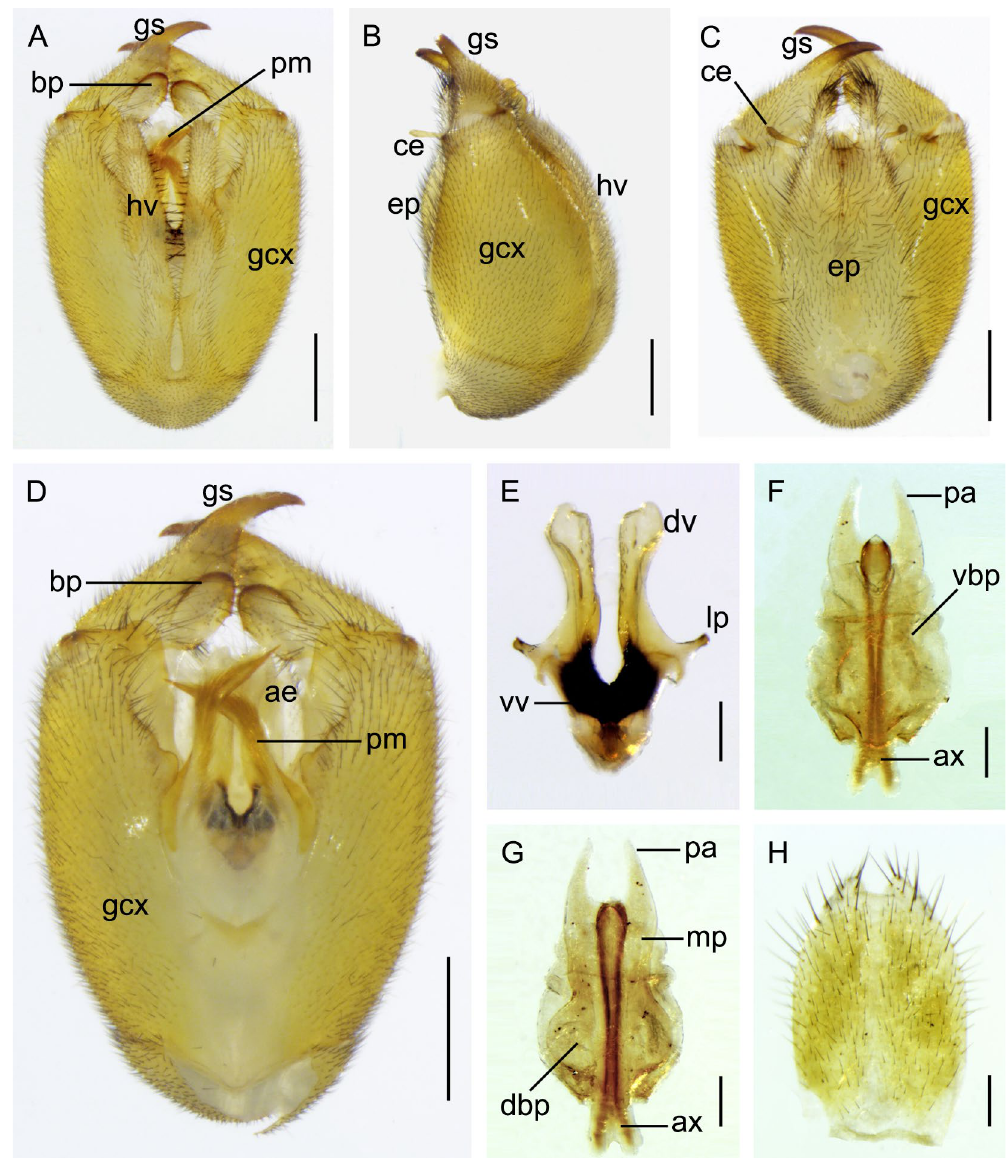
Fig. 10. Genitalia of Cerapanorpa xuebaodinga sp. nov. A–C . Male genital bulb in ventral, lateral and dorsal views. D . Male genital bulb with hypandrium removed in ventral view. E . Aedeagus in ventral view. F–G . Female medigynium in ventral and dorsal views. H . Female subgenital plate in ventral view. Abbreviations: ae = aedeagus; ax = axis; bp = basal process; ce = cercus; dbp = dorsal basal plate; dv = dorsal valve; ep = epandrium; gcx = gonocoxite; gs = gonostylus; hv = hypovalve; lp = lateral process; mp = main plate; pa = posterior arm; pm = paramere; vbp = ventral basal plate; vv = ventral valve. Scale bars: A–D = 0.5 mm; E–H = 0.2